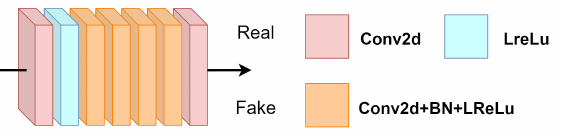
Figure 3. Discriminator. Driving the generator to capture the local information of the image can be highly advantageous in generating a dehazed image with relatively high